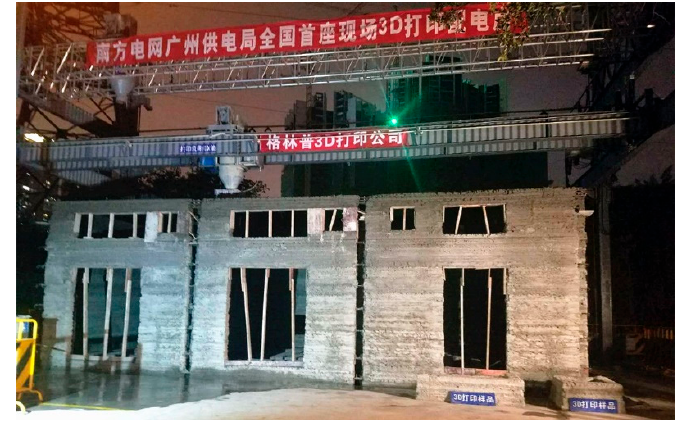
Figure 12. Power distribution substation after 3D printing.